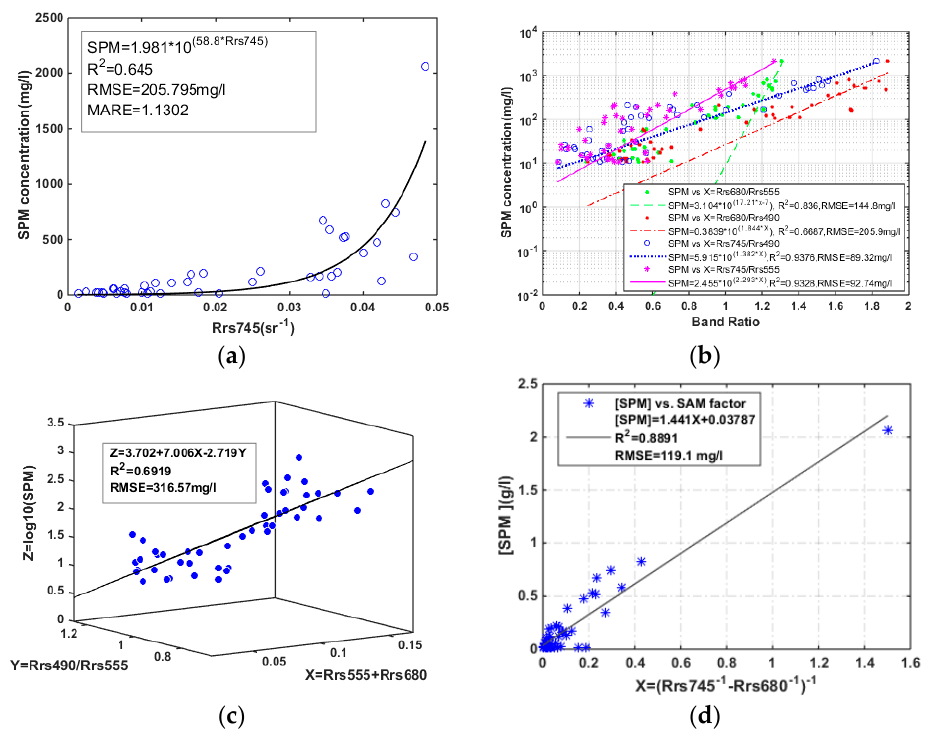
Figure 3 . The relationship between the field measured SPM concentration and R rs -derived variables. Figure 3. The relationship between the field measured SPM concentration and R